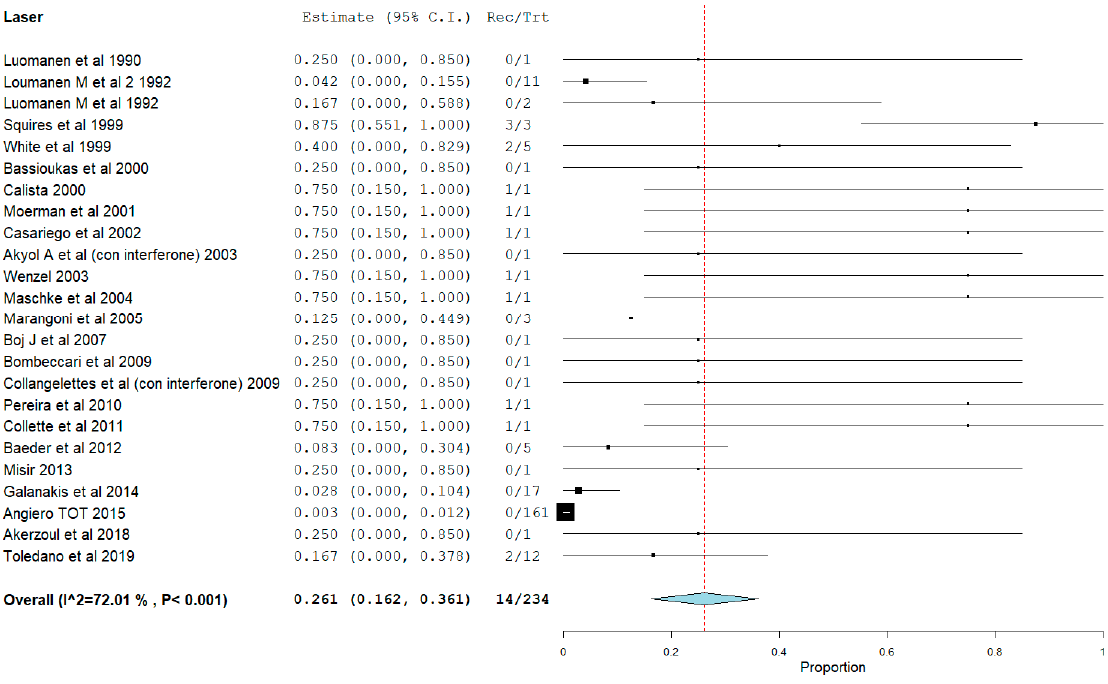
Figure 3. Forest-plot, laser excision studies.